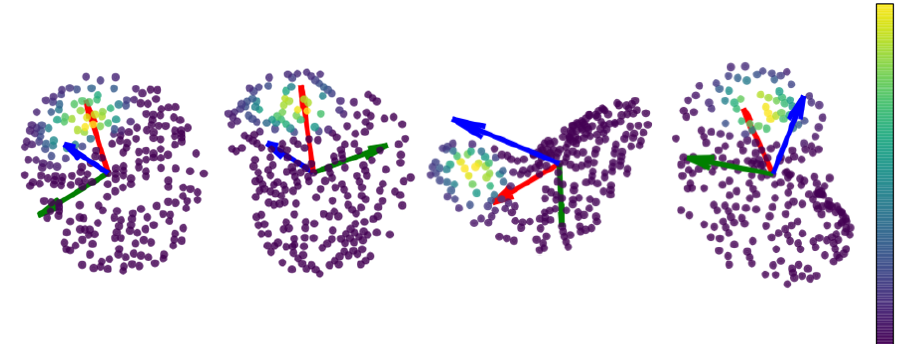
Figure 13. The visualization of the weights for every point in a local